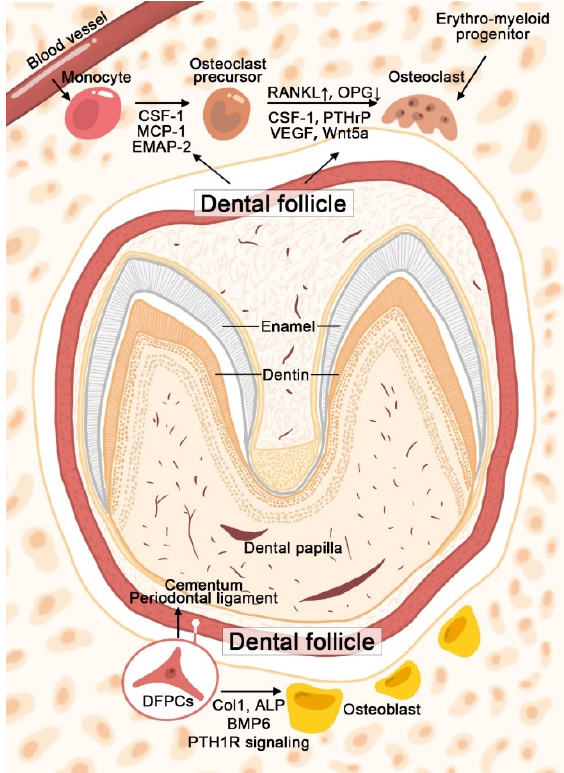
Figure 1. Schematic graph illustrates the mechanisms of DF/DFPCs in regulating osteoclast for- mation and osteoblast differentiation during tooth eruption. Colony-stimulating factor-one (CSF-1), monocyte chemotactic protein-1 (MCP-1), endothelial monocyte-activating polypeptide-2 (EMAP-2), receptor activator of nuclear factor kappa ligand (RANKL), osteoprotegerin (OPG), parathyroid hormone related peptide (PTHrP), vascular endothelial growth factor (VEGF), collagen type 1 (Col1), alkaline phosphatase (ALP), bone morphogenetic protein 6 (BMP6) and parathyroid hormone 1 receptor (PTH1R) .